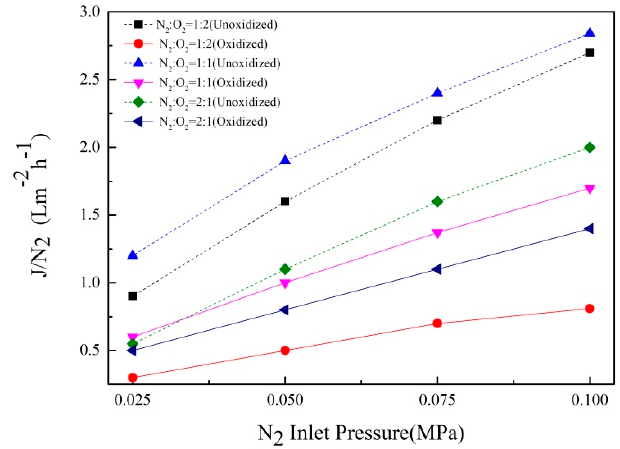
Figure 6. Gas flux of Ti support after oxidation at 800 °C for 60 min, at different oxygen concentrations.